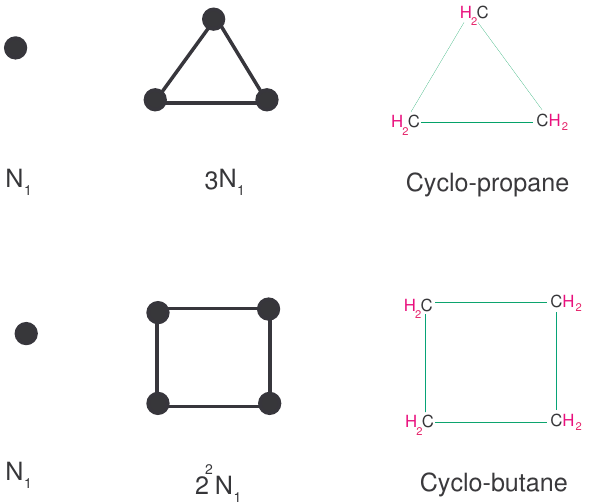
Figure 2. η ζ Γ as organic compounds. Carbon Nanotube TUC 4 ( m , 3 ) as 3 P n